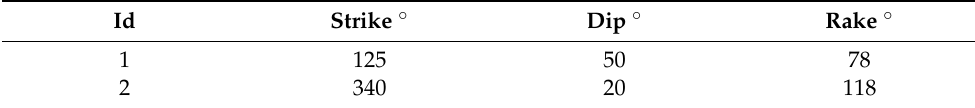
Table 6. Optimally oriented faults.